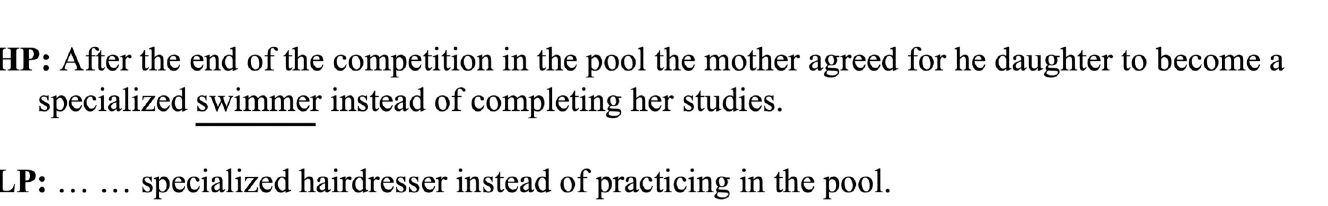
Fig 3. A sample stimuli set for Experiment 3. The target words are underlined in the Arabic frame sentences and the English translation. HP and LP are high- and low-predictability target words conditions, respectively, and LPD is the diacritized low-predictability condition.